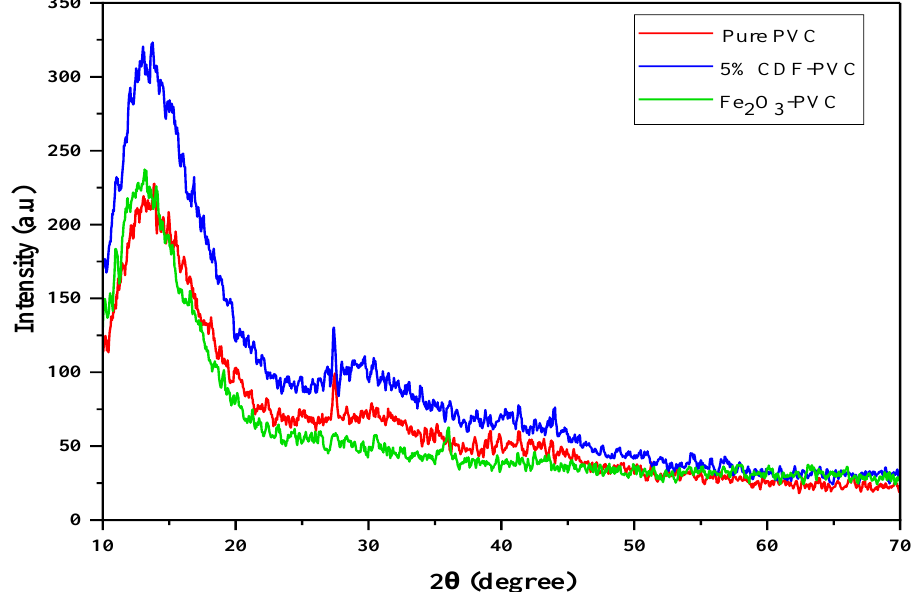
Figure 3. The comparison of XRD patterns of PVC and its composites.